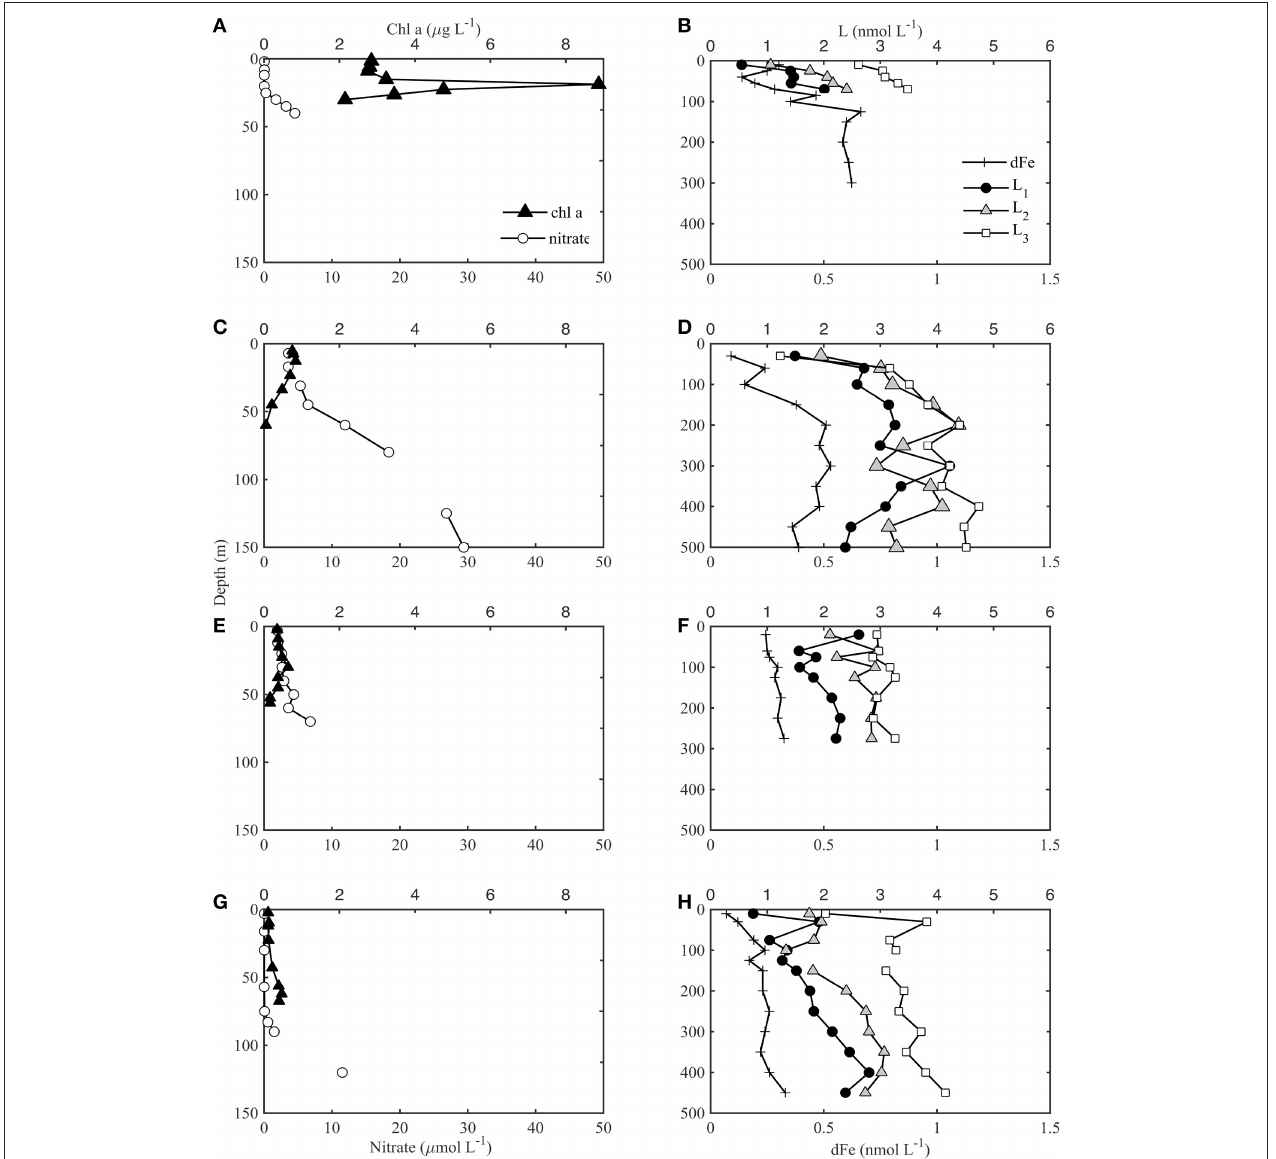
FIGURE 2 | Chl a and nitrate (nitrate + nitrite) bottle samples shown in left panels for coastal station 4 (A), frontal stations 1 (C), and 6 (E), and oceanic station 2 (G) according to characteristics defined in Krause et al. (2015). The dFe ( + ) and ligand concentrations (L 1 black circles, L 2 gray triangles, L 3 white squares) for the corresponding station are shown in right panels (B,D,F,H) . Note the different depth scales of left and right panels.